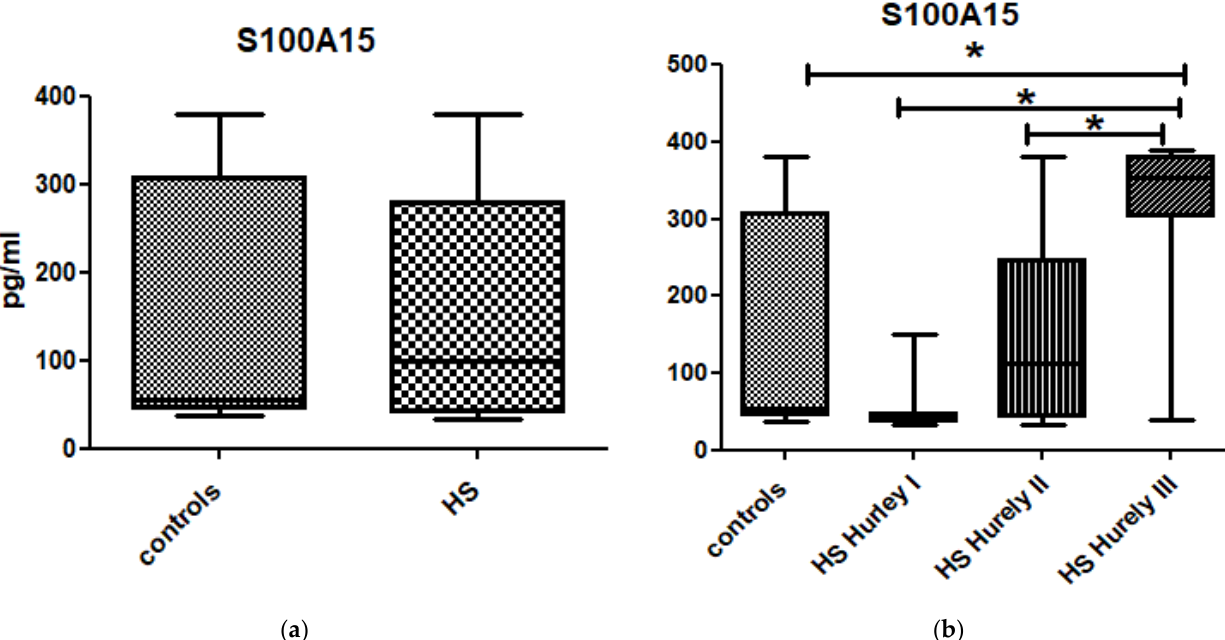
Figure 3. ( a ). There was no significant difference in serum concentrations of S100A15 between patients suffering from HS and controls ( p > 0.05). ( b ). There was statistically significant difference in S100A15 serum concentrations between Hurley stages ( p < 0.0001). The serum concentrations of S100A15 in patients in Hurley III stage were significantly elevated as compared to controls, individuals with HS in Hurley I stage and individuals with HS in Hurley II stage ( p = 0.0013, p < 0.0001 and p = 0.0004 respectively). * is statistically significant result p < 0.05. The ROC curve analysis showed an AUC of 0.81 (95%CI for AUC: 0.66–0.97) ( p =